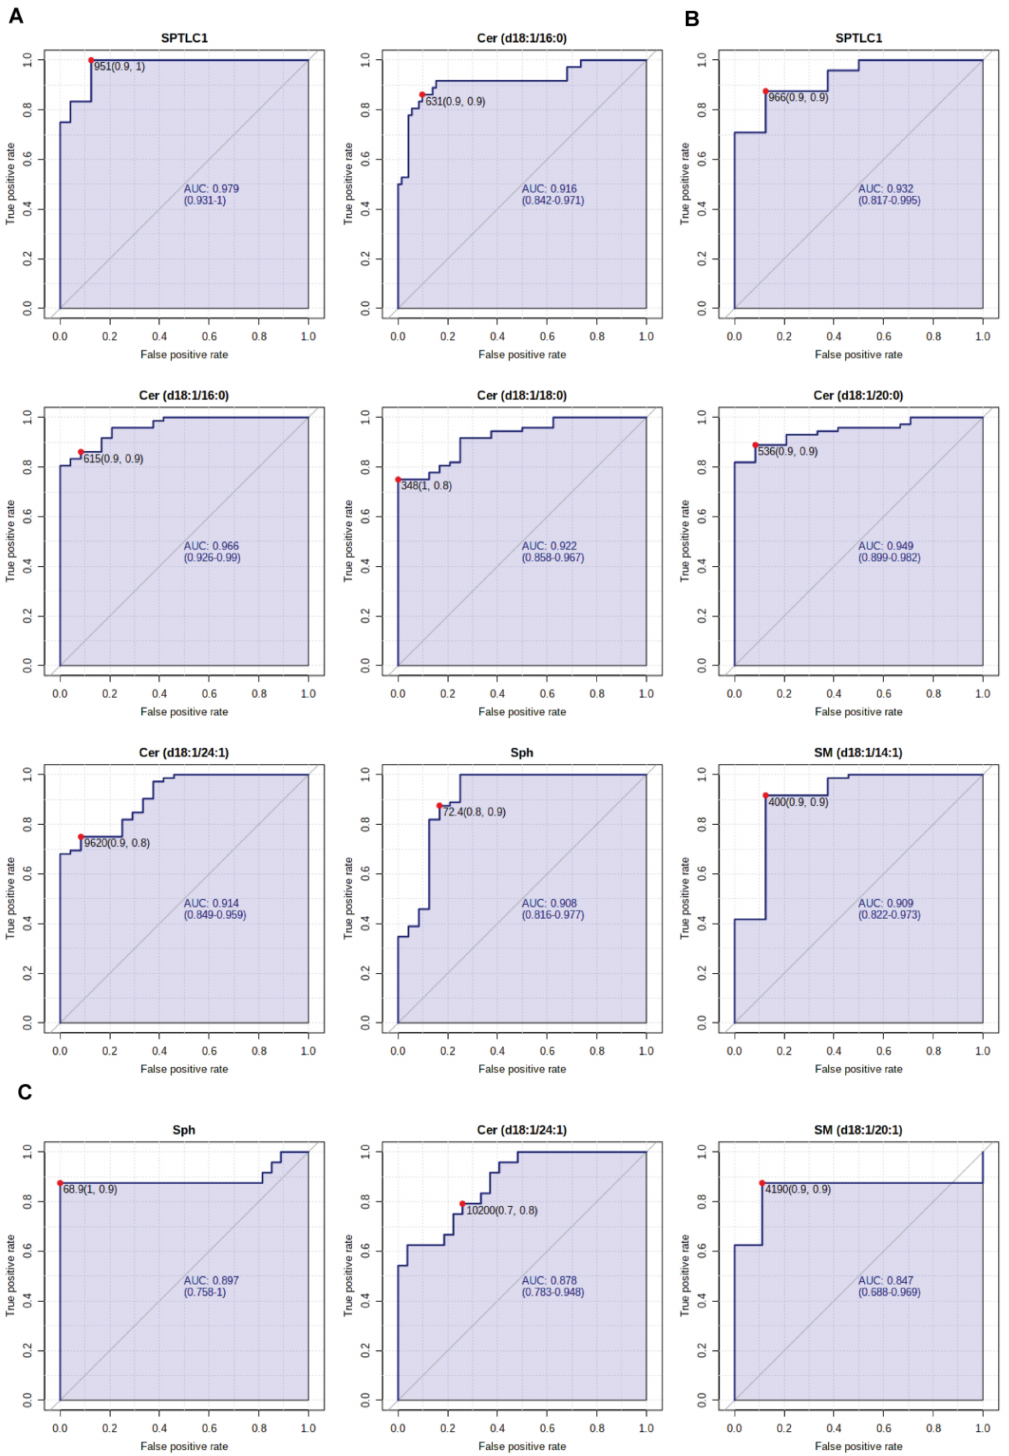
Figure 9. ( A ) ROC curve analyses of SPTLC1 and Cer C16:0 for patients with severe COVID-19 disease and HC subjects; ( B ) ROC curve analyses of SPTLC1, Cers C16:0, C18:0, C20:0, C24:1, Sph, SM C14:1 for patients with critical COVID-19 disease and HC subjects; ( C ) ROC curve analyses of Sph, Cer C24:1, SM C20:1 for patients with critical and mild COVID-19 disease. AUC values and 95% confidence intervals are reported, as well as cut-off values and sensitivity and specificity values in